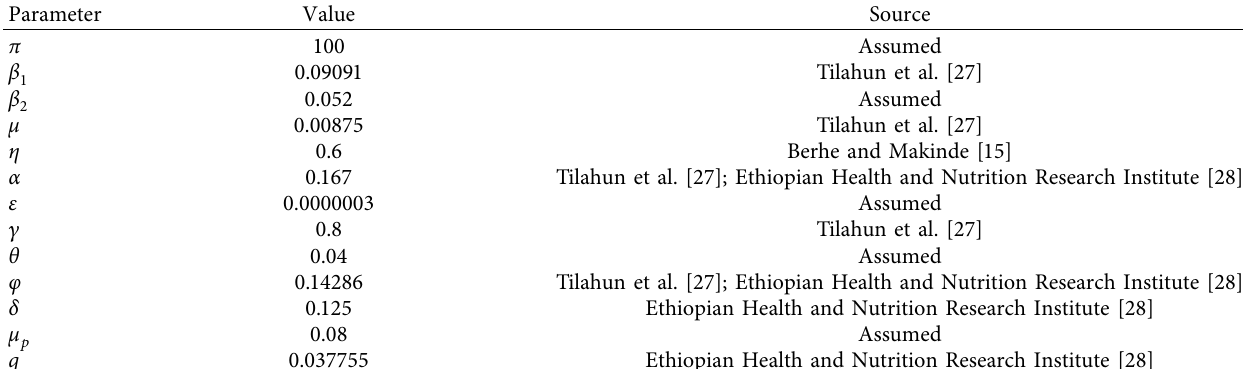
Table 4: Parameter values and their sources.